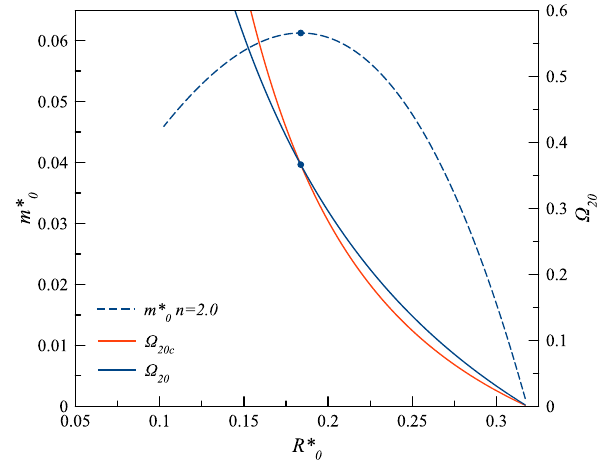
( R ∗ ) diagram for the EOS P = βσ 2 , 0 0